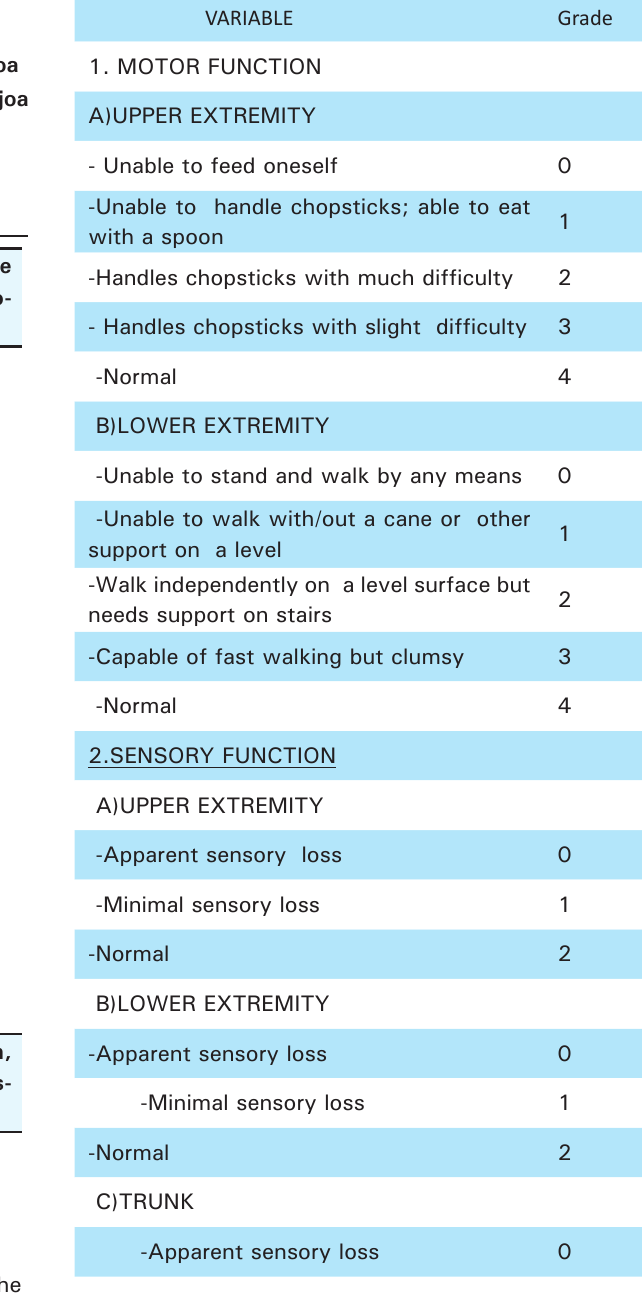
table 2. Japanese Orthopaedics Association